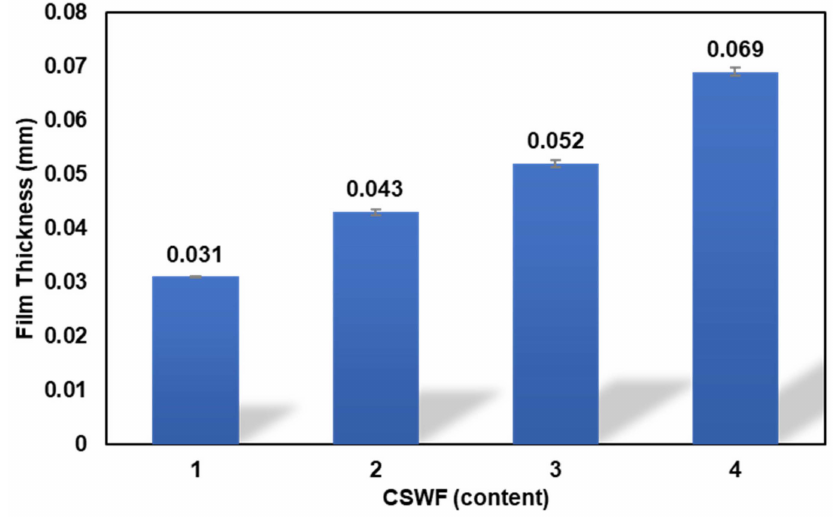
Figure 2. Thickness of PBS/CSWF composite films.